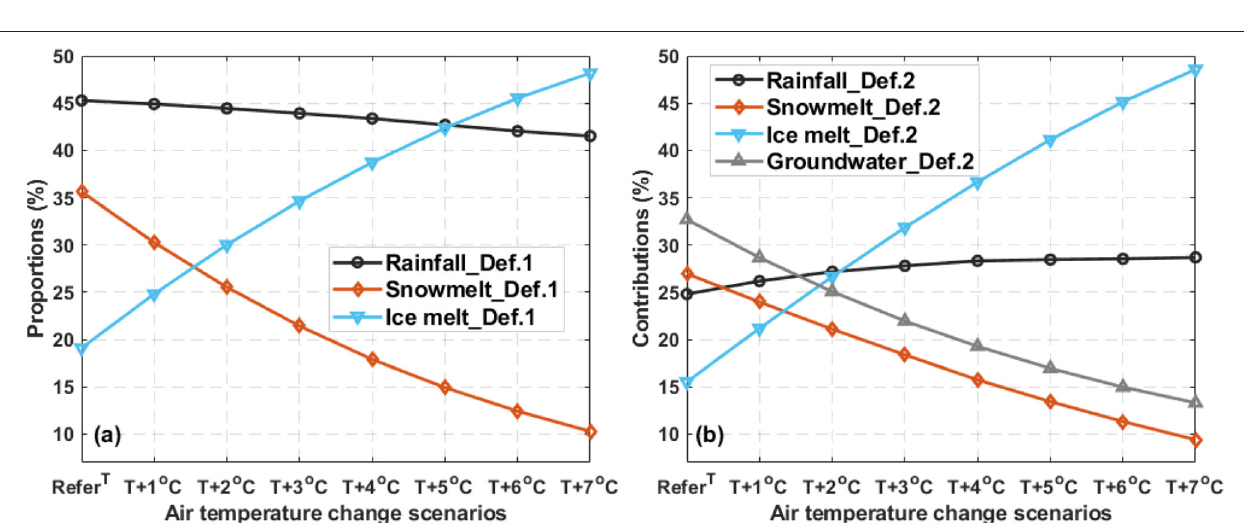
FIGURE 5 | Changes of annual proportions of water inputs and contributions of runoff components, in response to temperature warming. “Def. 1” is for the definition of water input source, and “Def. 2” refers to the definition of runoff components based on flow pathway. Dots indicate mean values during the 20-year modeling period. rainfall, snowmelt and ice melt in the total water input are around 45, 36, and 19%, respectively; whilst their proportions will be 42, 10, and 48% in the 7 ◦ C warming scenario.